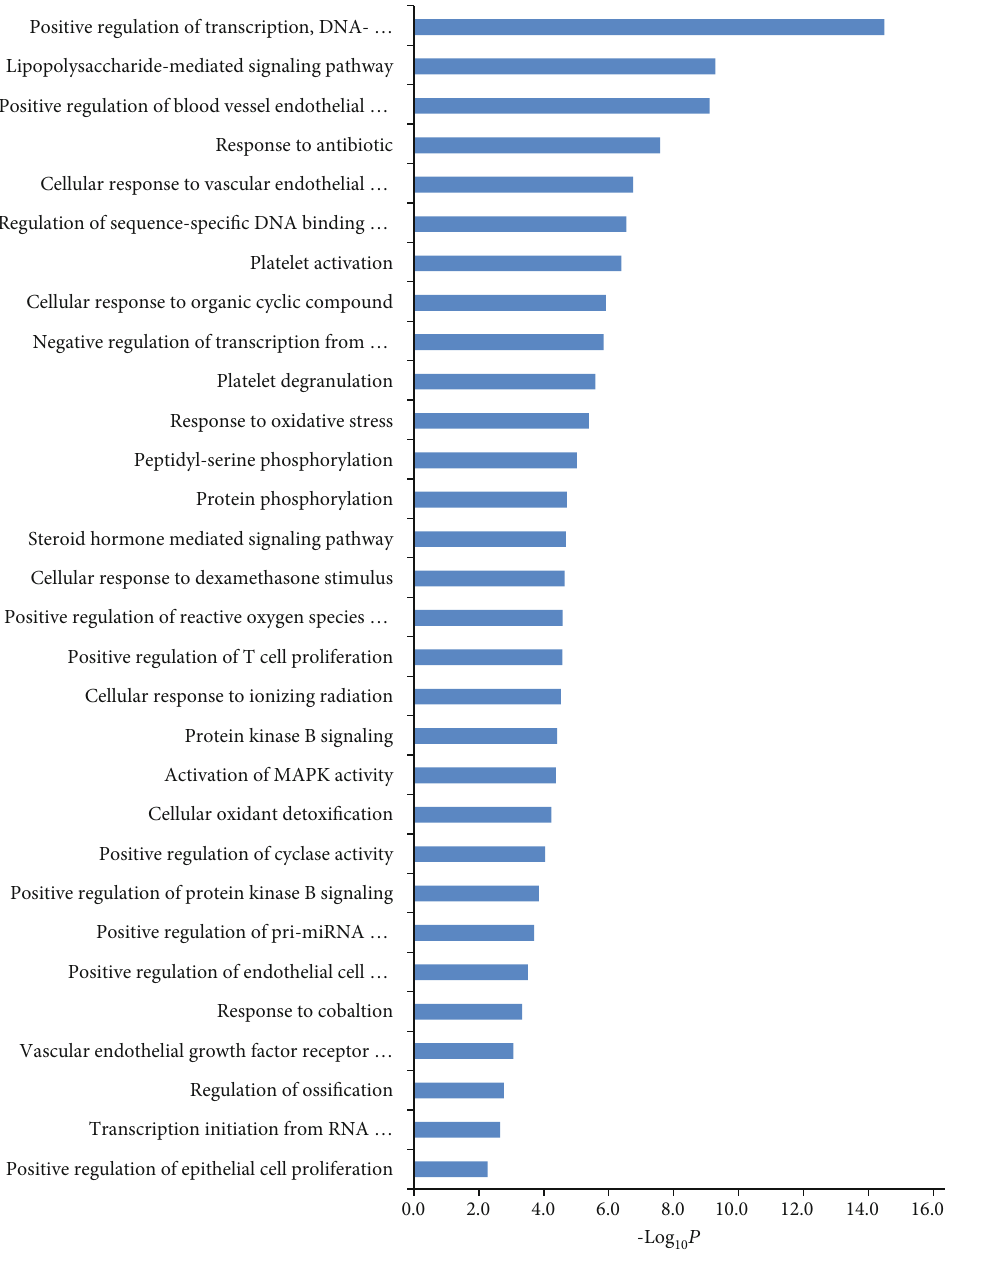
Figure 6: The top 30 enriched Gene Ontology (GO) terms for biological process (BP) were analyzed by DAVID system under the condition with P value <